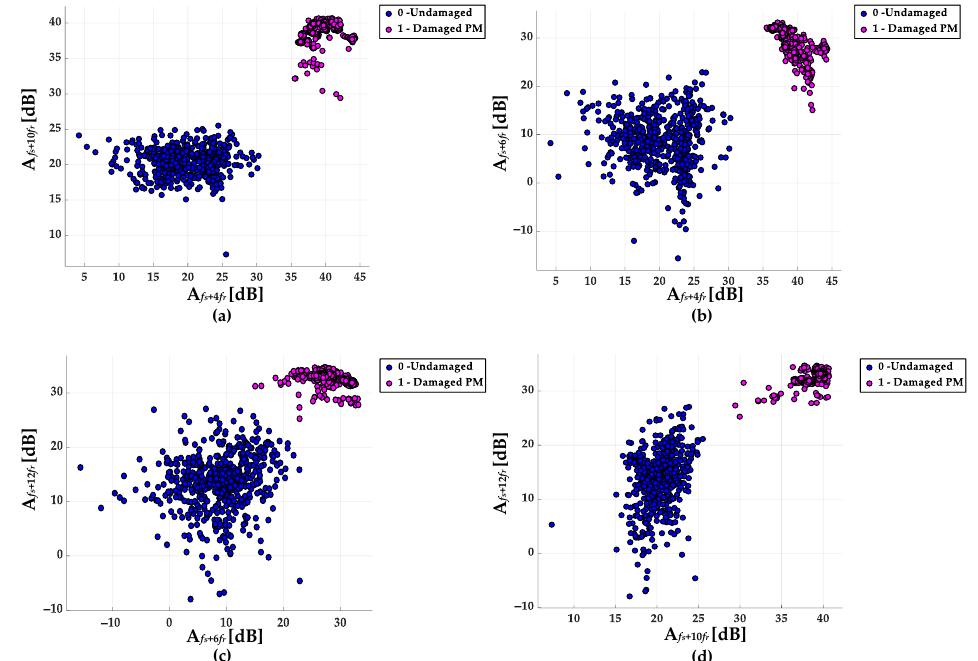
Figure 11. Distribution of the proposed fault features pairs for undamaged and damaged PM ( a ) (A fs +4 fr , A fs +10 fr ), ( b ) (A fs +4 fr , A fs +6 fr ), ( c ) (A fs +6 fr , A fs +12 fr ), ( d ) (A fs +10 fr , A fs +12 fr ).